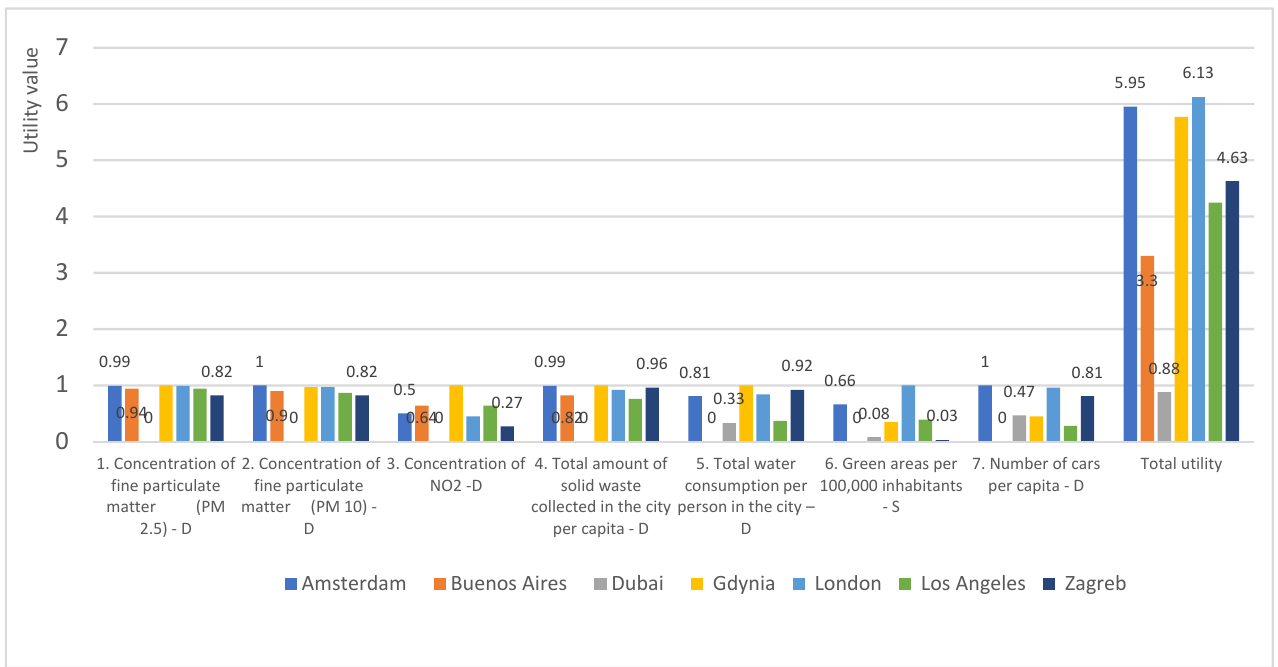
Figure 1. Partial and total utility for the environmental dimension indicators in selected cities.